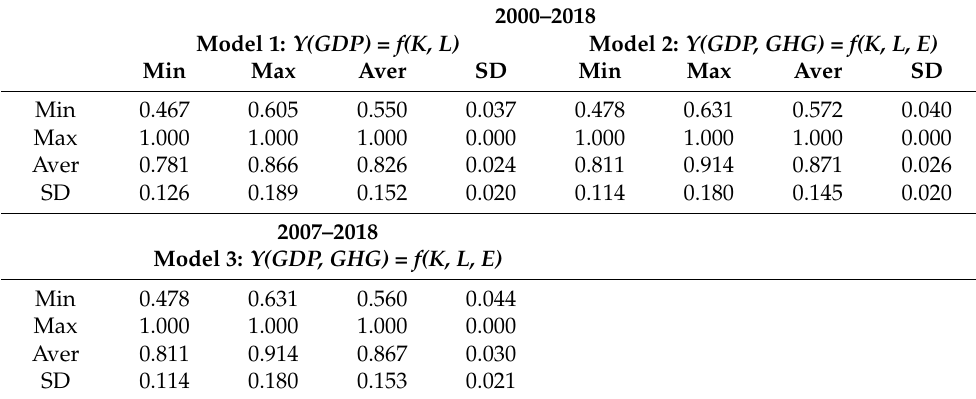
Table 2. Average efficiency scores for Models